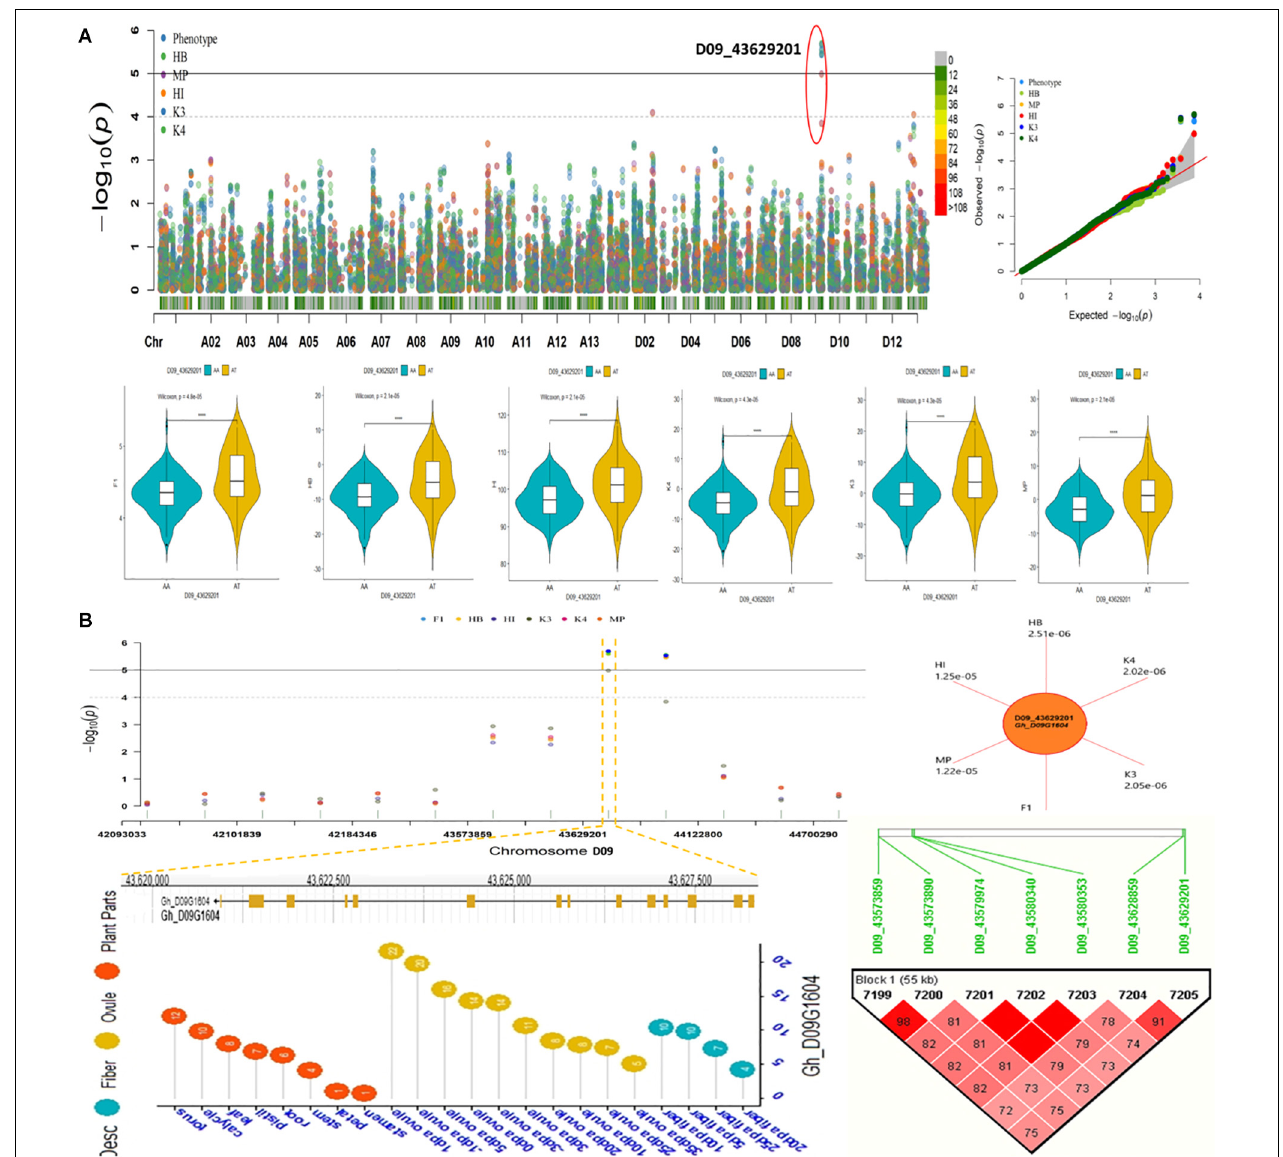
FIGURE 10 | (A) Summary of GWAS results for Fiber micronaire (MIC) including Manhattan plots, QQ plots, violin plots displaying differences for MIC among two haplotypes of SNP/hQTN D09_43629201 in trait phenotype and five heterosis types. (B) Regional Manhattan plots showing presence of hQTN D09_43629201 in trait phenotype and five types of heterosis further narrowing down to genomic location of gene hqMICD09_43629201_C on chromosome D09, sun plot displaying the p -values of variables harboring hqMICD09_43629201_C and gene Gh_D09G1604, Expression levels of representative gene associated with MIC during different growth stages and Haplotype region (55 kb) surrounding the peak on chromosome D09 associated with